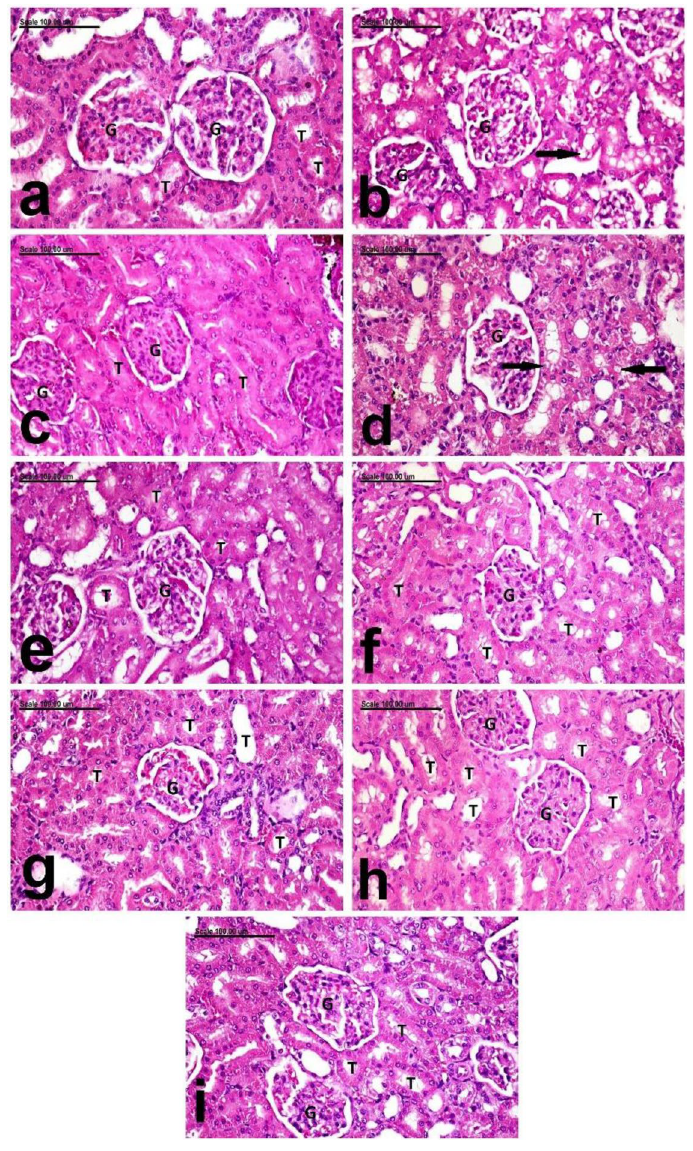
Figure 7. Photomicrograph showing the pathological alterations of the renal tissue. photomicrograph from the kidneys of, ( a ) negative control rats showing normal renal tubules (T) and glomeruli (G), ( b ) C+ ve showing vacuolation of individual cells (arrow) lining the renal tubules, ( c ) Prednisolone treated group showing normal renal tubules (T), ( d ) the low dose leave group showing vacuolization of some renal tubular epithelial cells (arrows), ( e ) the high dose leave group showing normal renal tubules (T), ( f ) low stem-treated groups showing normal histological structures, ( g ) high dose stem-treated groups showing normal renal parenchyma, ( h ) low dose fruit peels treated group showing normal histological structures, and ( i ) high dose fruit peels treated groups showing normal renal parenchyma. (Stain: H&E; Scale bar = 100